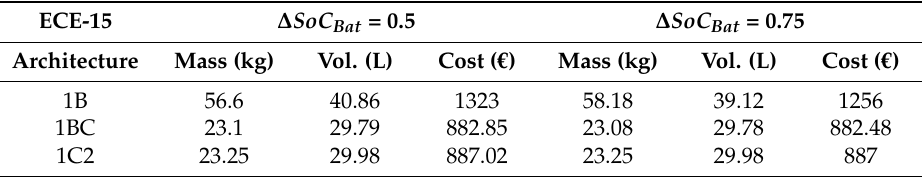
Table 9. Mass, volume, and overall cost of the electric power distribution systems selected from each group of architectures, with variations in the battery charge state of 50% and 75%, for the ECE-15 driving profile. ∆ SoC Bat = 0.5